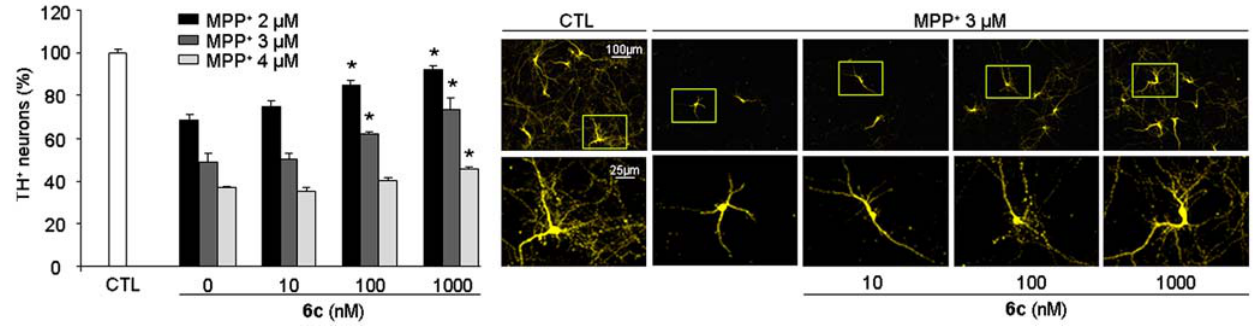
Figure 4. Protective effect of compound 6c against neurotoxin 1-methyl-4-phenylpyridinium (MPP + ) toxicity. (A) Treatment of MPP + - treated mesencephalic cultures with compound 6c resulted in the partial rescue of DA neurons in a dose-dependent manner. Cultures were maintained from DIV1 to DIV8 in the presence or absence of compound 6c and were treated with MPP + for 48 h from DIV5 to DIV7. Neuronal survival was quantified by counting TH + immunolabeled neurons at DIV8. Values are normalized to a toxin-free control and represent the average of three assays performed in triplicate expressed as mean 6 SEM. Statistical analysis was performed by one-way ANOVA followed by Dunnett’s post hoc test. *P , 0.001. (B) Compound 6c treatment reduced MPP + -induced neurite degeneration. Images illustrate untreated (CTL) and treated (MPP + , 6c ) cultures. Images were acquired with an inverted fluorescent microscope coupled to a digital camera.